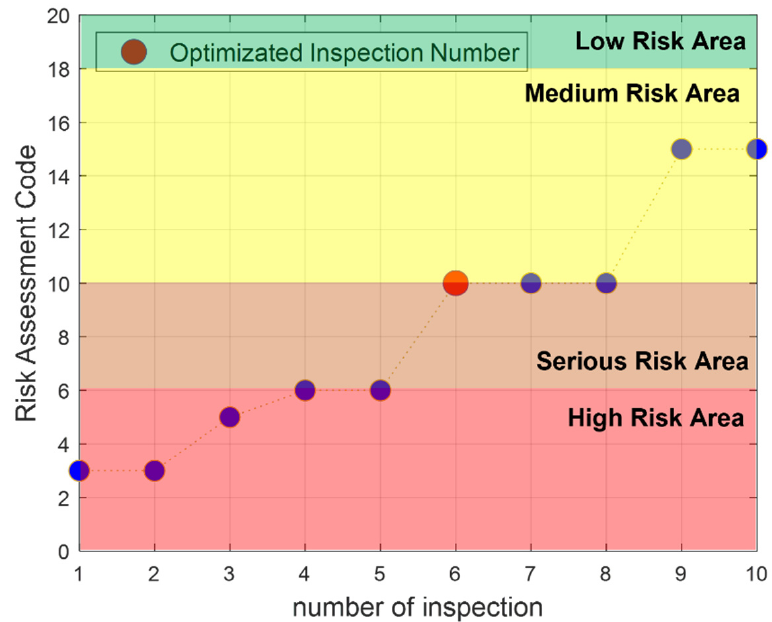
Figure 17. Selection of optimized inspection from the RAC-vs.-severity-level curve.